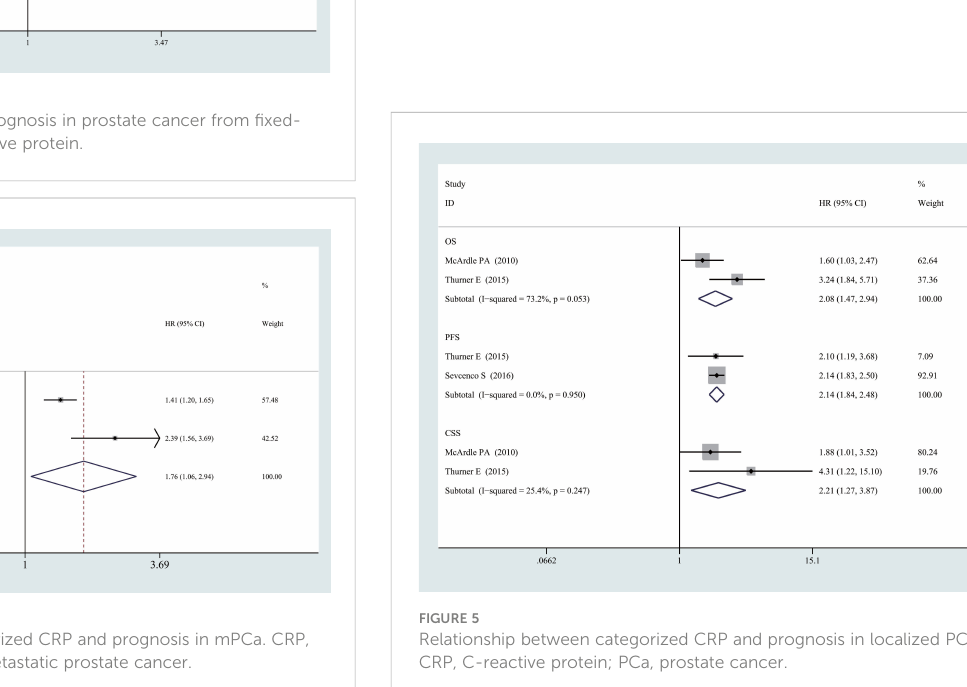
FIGURE 5 Relationship between categorized CRP and prognosis in localized PCa. CRP, C-reactive protein; PCa, prostate